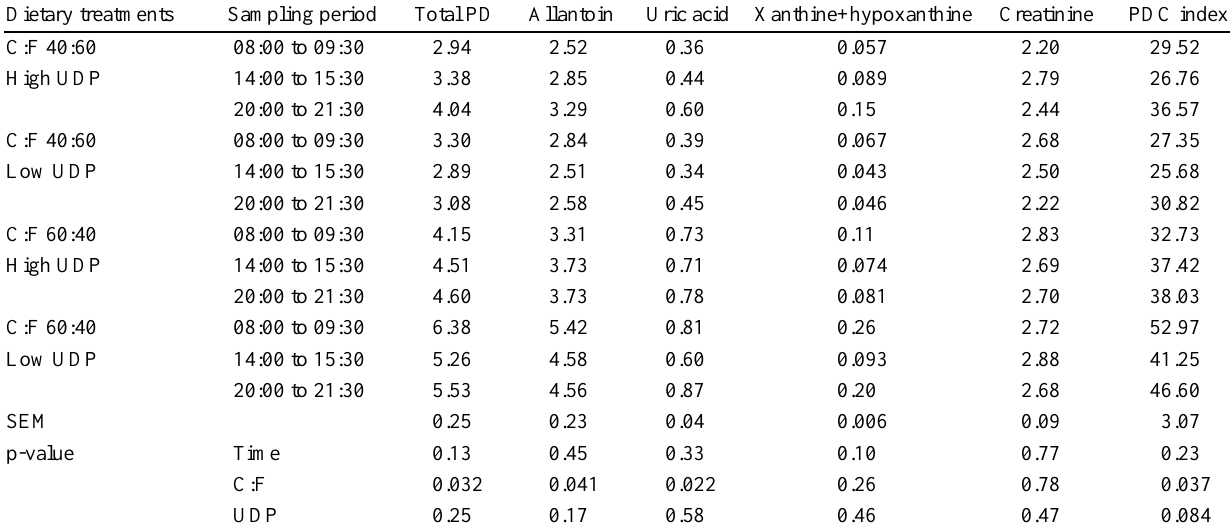
Table 4. Urinary purine derivatives, creatinine concentrations, and PDC index in spot urine of lambs Dietary treatments Sampling period